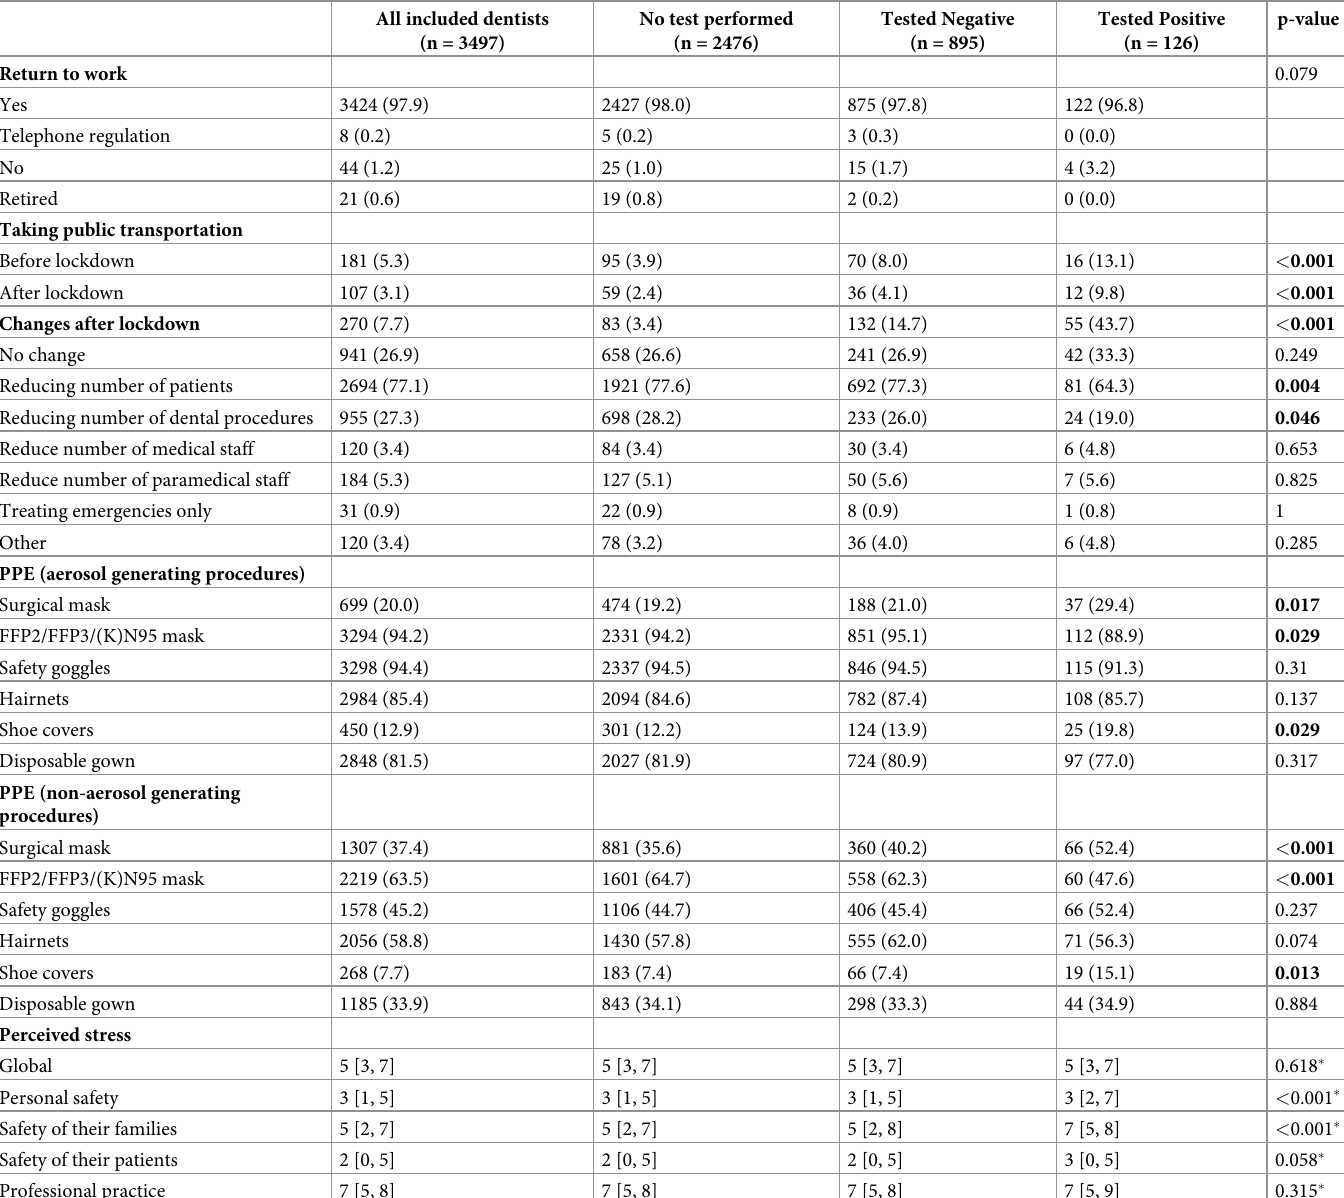
Table 3. Clinical practice and perceived stress after the lifting of the